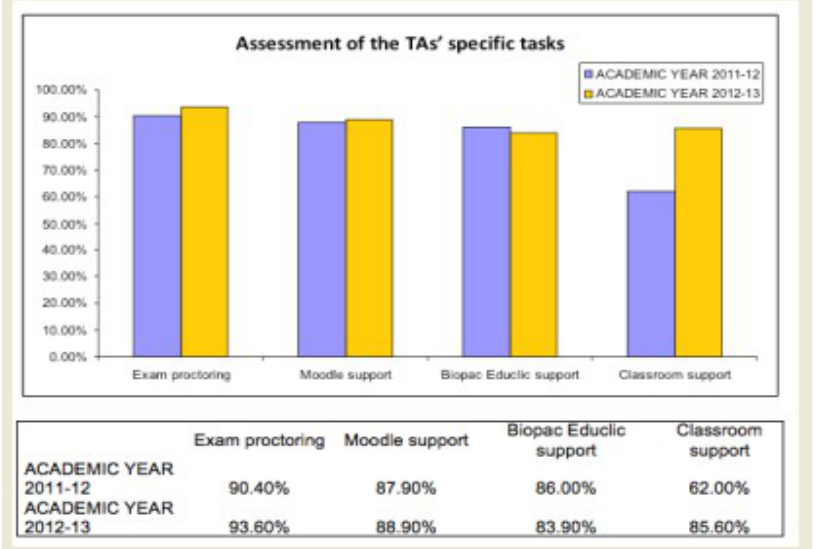
Figure 3. Assessment of the TAs’ specifc